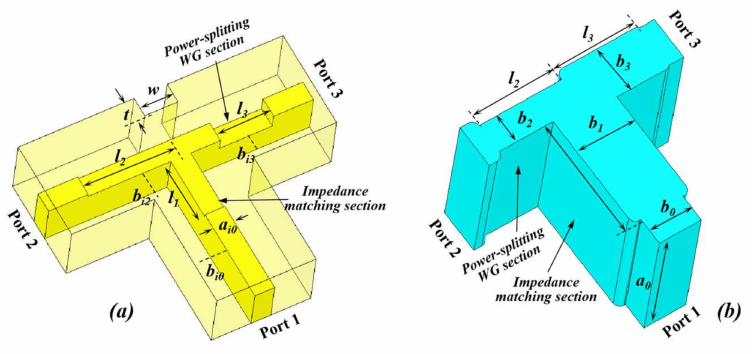
Figure 8. Basic units of the two power-tapering feed networks: ( a ) UPEP RGWG H-T-junction; ( b ) UPEP RWG